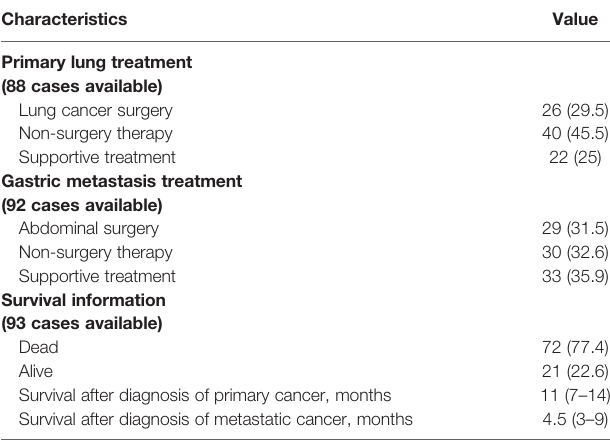
TABLE 3 | Treatment and prognosis features of primary and metastatic tumors.